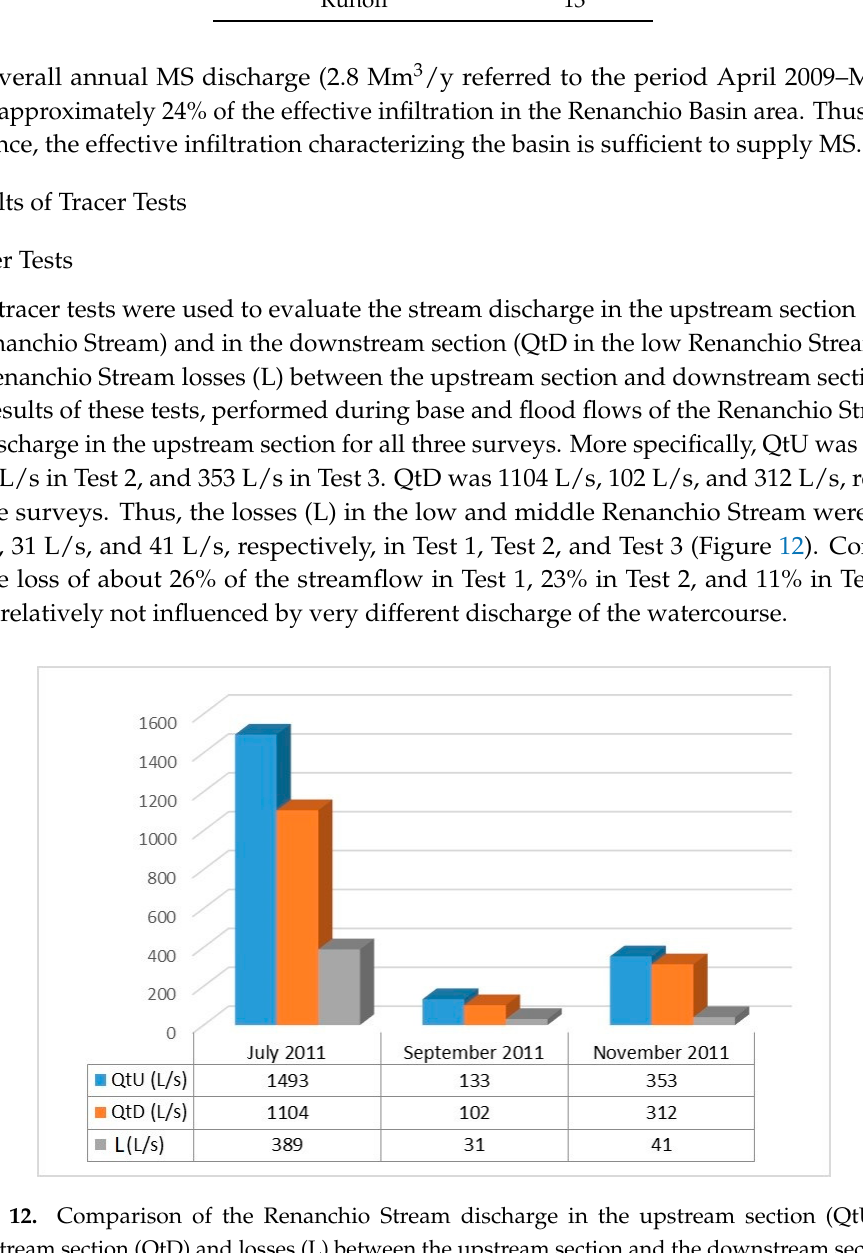
Table 4. Main annual parameters of the hydrologic balance of the Renanchio Basin.